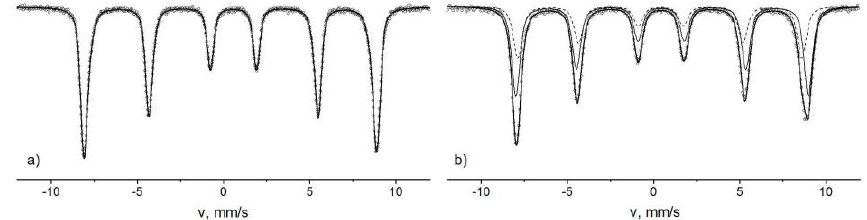
Figure 6. Mössbauer spectra of α-Fe 2 O 3 nanoparticles d ≈ 30 nm ( a ) and γ-Fe 2 O 3 ( b ) d ≈ 27 nm measured at 15 K.